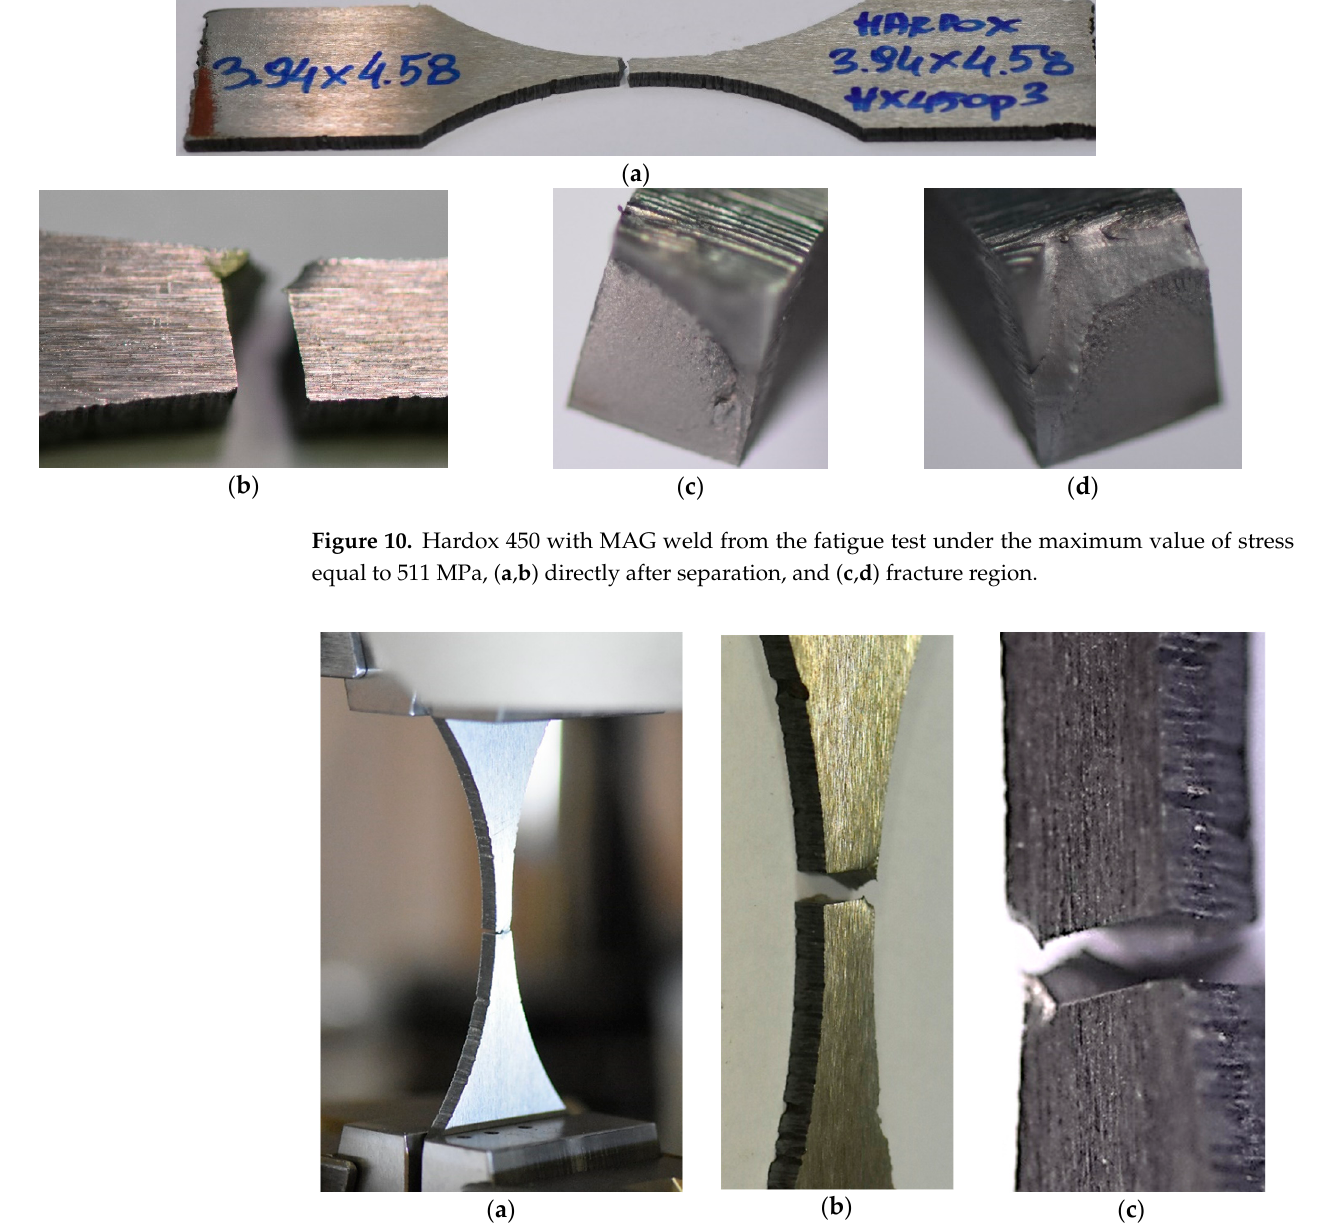
Figure 11. Hardox 450 with MAG weld from the fatigue test under the maximum value of stress equal to 340 MPa, ( a , b ) directly after separation, and ( c ) fracture region.